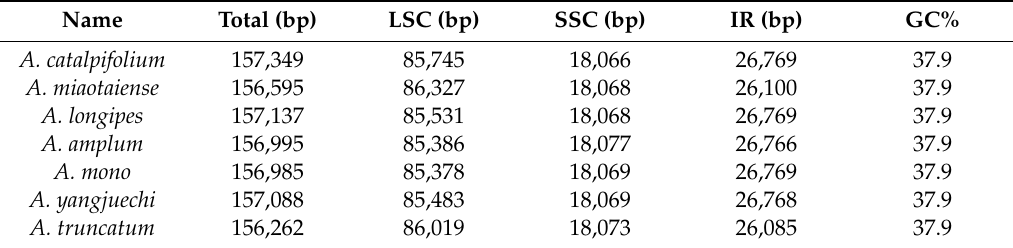
Table 1. General features of the Acer sect. Platanoidea chloroplast genomes compared in this